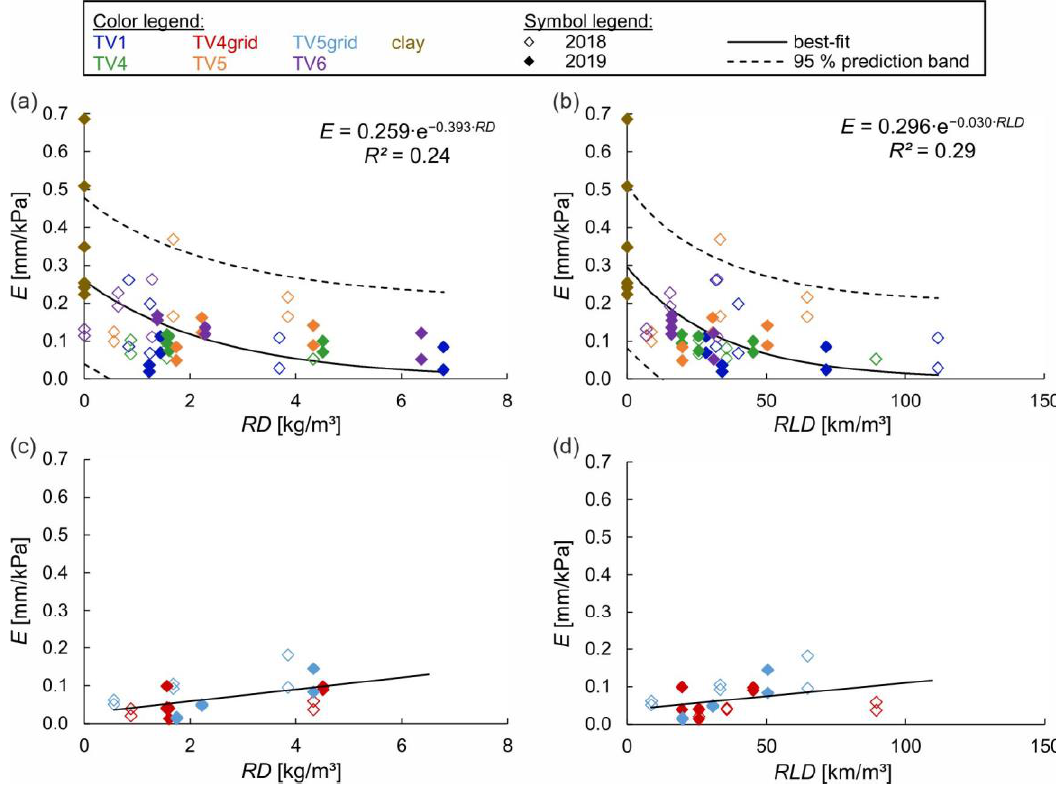
Figure 8. Erosion rate E as function of the root density RD (left) and root length density RLD (right) for different vegetated covers. ( a ) and ( b ) show data of unreinforced vegetated covers; ( c ) and ( d ) show data of vegetated covers reinforced with a three-dimensional geogrid. TV1 = species-poor grass-dominated mixture, TV4 = grass-herb mixture, TV5 = species-rich herb-dominated EcoDike mixture, TV6 = species-rich herb-dominated ready-mix, and grid = geogrid reinforcement.